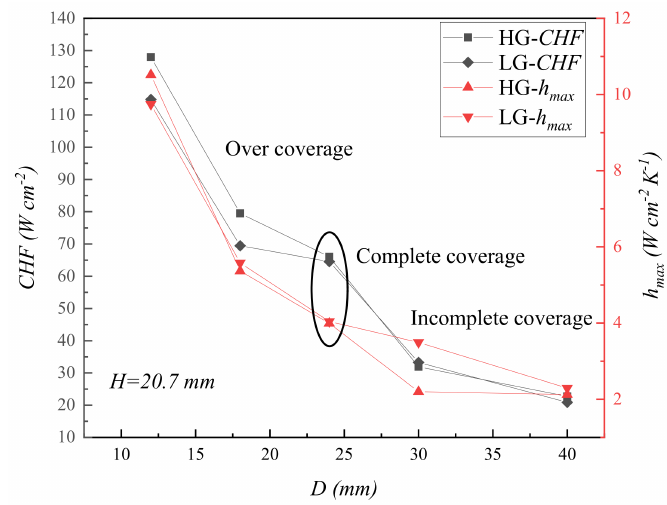
Figure 15. CHF and h max versus D at H = 20.7 mm.